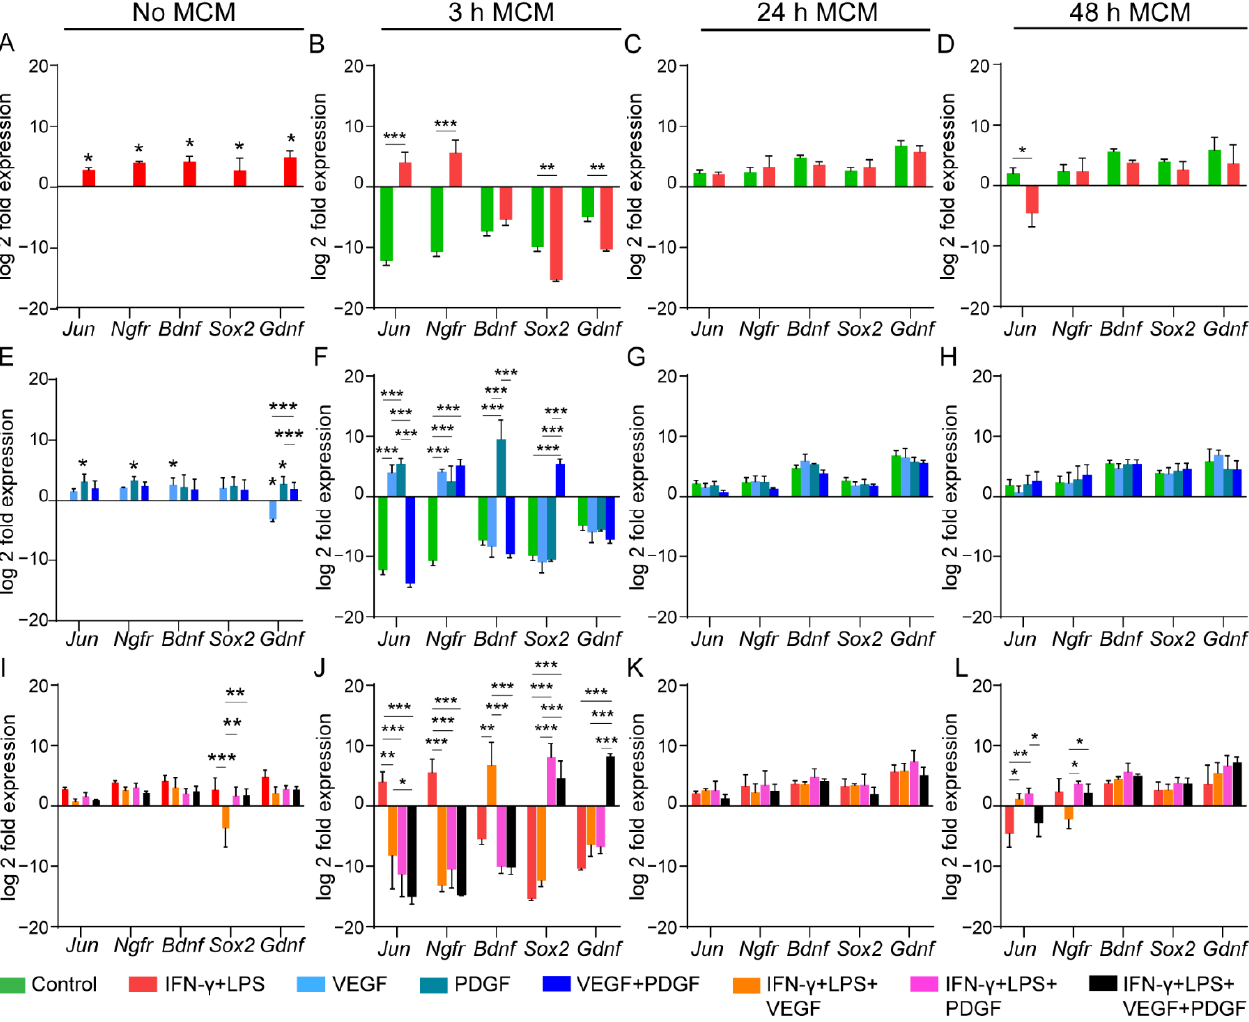
Figure 4. Effect of unconditioned and macrophage conditioned media (MCM) with or without VEGF, PDGF on nerve repair associated gene expression in primary OECs. ( A – L ) Graphs represent the log 2-fold expression of genes responsible for nerve repair in OECs when treated with unconditioned media (No MCM), 3 h, 24 h and 48 h MCM. ( A – D ) Untreated control and IFN- γ + LPS media for ( A ) Unconditioned media, ( B ) 3 h MCM, ( C ) 24 h MCM, ( D ) 48 h MCM; ( E – H ) Untreated control vs. VEGF vs. PDGF vs. combined VEGF + PDGF ( E ) Unconditioned media, ( F ) 3 h MCM, ( G ) 24 h MCM, ( H ) 48 h MCM; ( I – L ) IFN- γ + LPS vs. IFN- γ + LPS + VEGF vs. IFN- γ + LPS + PDGF vs. IFN- γ + LPS + VEGF + PDGF for ( I ) Unconditioned media, ( J ) 3 h MCM, ( K ) 24 h MCM, ( L ) 48 h MCM. Normalisation was done on no MCM control data. * p ≤ 0.05, ** p ≤ 0.01, *** p ≤ 0.001 measured using unpaired t -test for ( A – D ); two-way ANOVA with Fisher’s LSD test for ( E – L ). Error bar represents mean ± SEM for three technical replicates of three biological